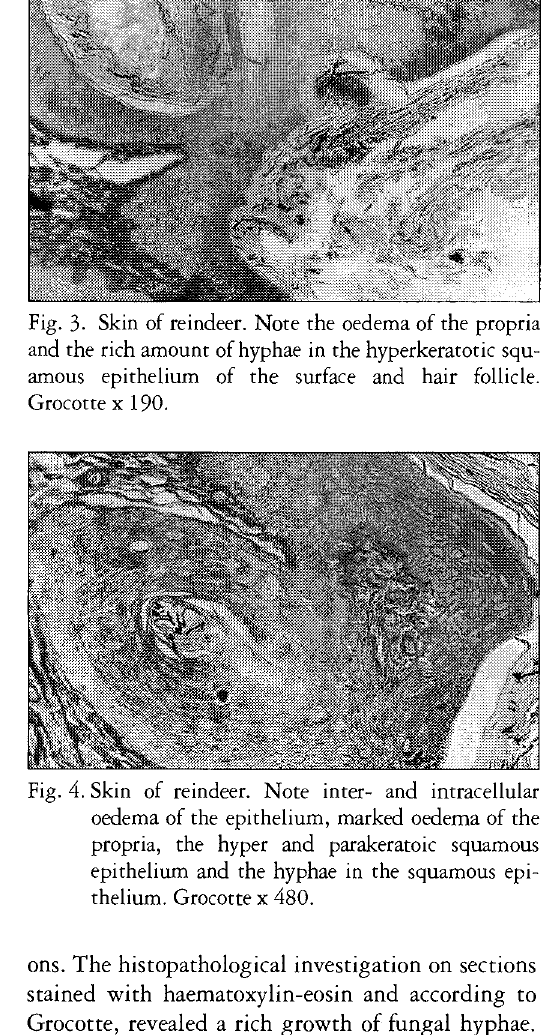
Fig. 4. Skin of reindeer. Note inter- and intracellular oedema of the epithelium, marked oedema of the propria, the hyper and parakeratoic squamous epithelium and the hyphae in the squamous epi thelium. Grocotte x